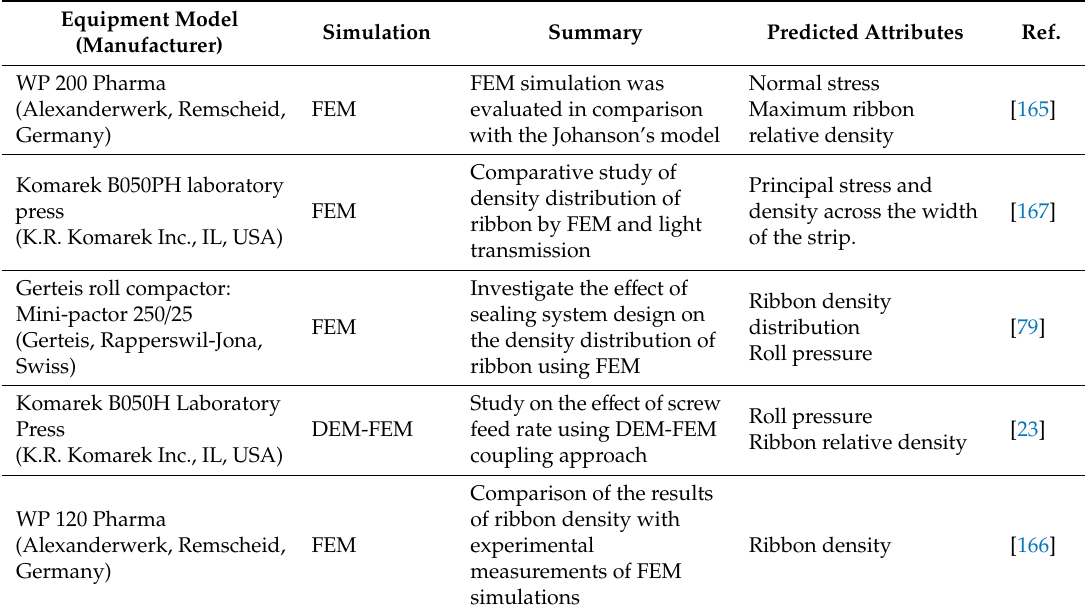
Table 8. Summary of physics-based modeling method applied in dry granulation